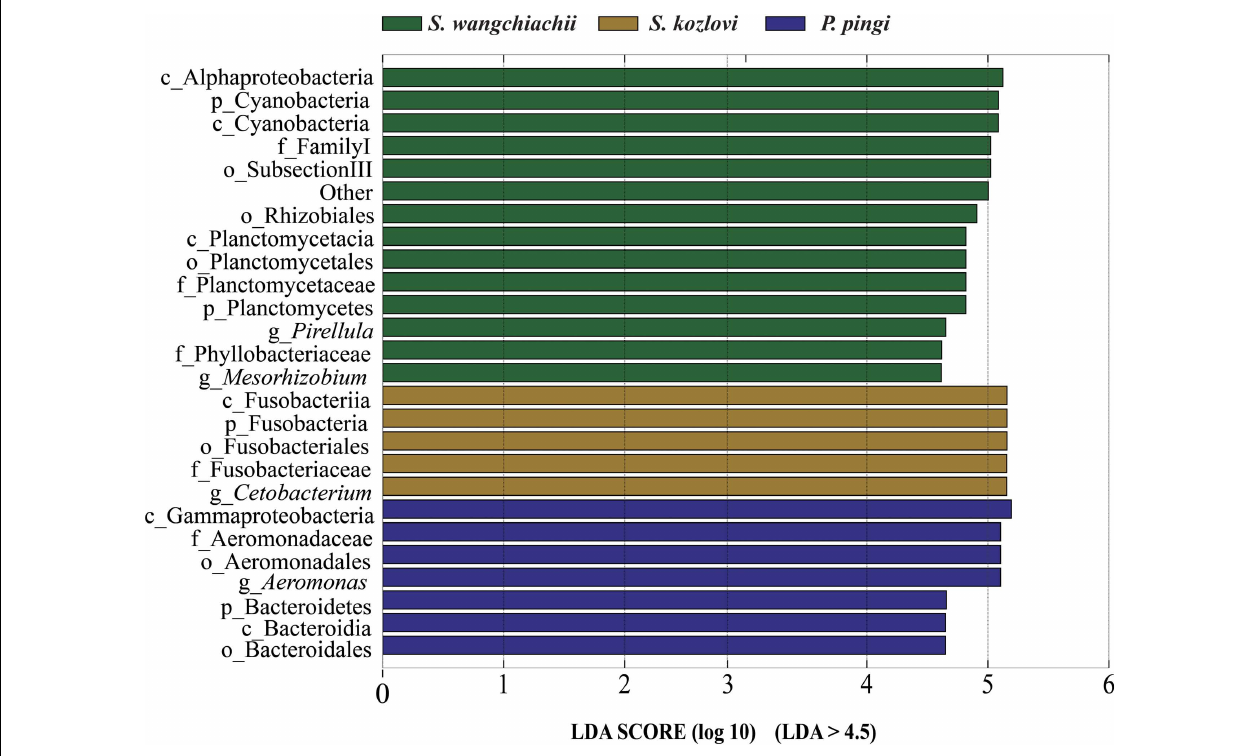
FIGURE 3 | Variation in the composition of the three cold-water fishes. Linear discriminant analysis effect size (LEfSe) analysis of gut microbiota composition of the three fish species (LDA > 4.5).